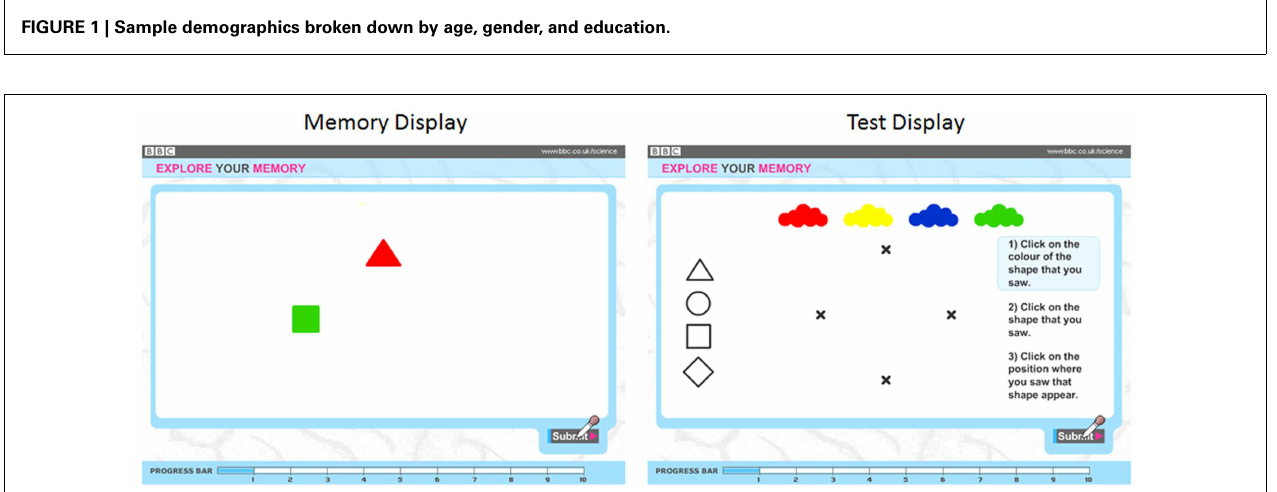
FIGURE 2 | Sample memory (left) and test (right) displays used during the experiment. In this example, the observer is to remember the color, shape, and location of two